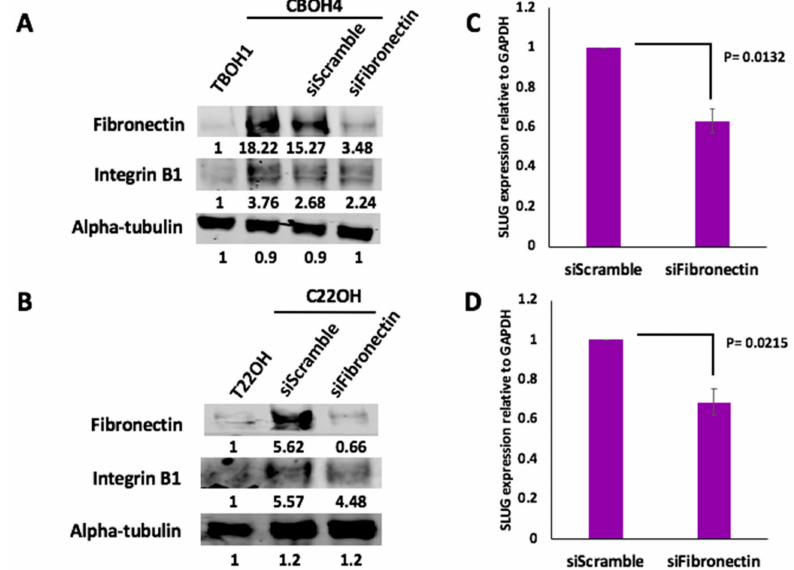
Figure 5. Fibronectin knockdown in CTCs caused decreased integrin B1 and SLUG expression. ( A , B ) After a 24 h transfection of CBOH4 and C22OH with fibronectin-specific siRNAs, western blotting was performed to determine the e ff ects on integrin B1 expression. Western blotting revealed that fibronectin knockdown in CTCs was successful. The e ff ect of fibronectin knockdown on integrin B1 expression was compared in control untransfected cells, CTCs transfected with scramble siRNAs, and CTCs transfected with fibronectin-specific siRNAs. Western blotting experiments were performed three separate times. ( C , D ) E ff ect of Fibronectin knockdown on SLUG expression in CBOH4 and C22OH CTCs was assessed by qPCR. Expression was normalized against GAPDH. Data provided on graphs are presented as mean ± standard error of the mean (SEM); N =